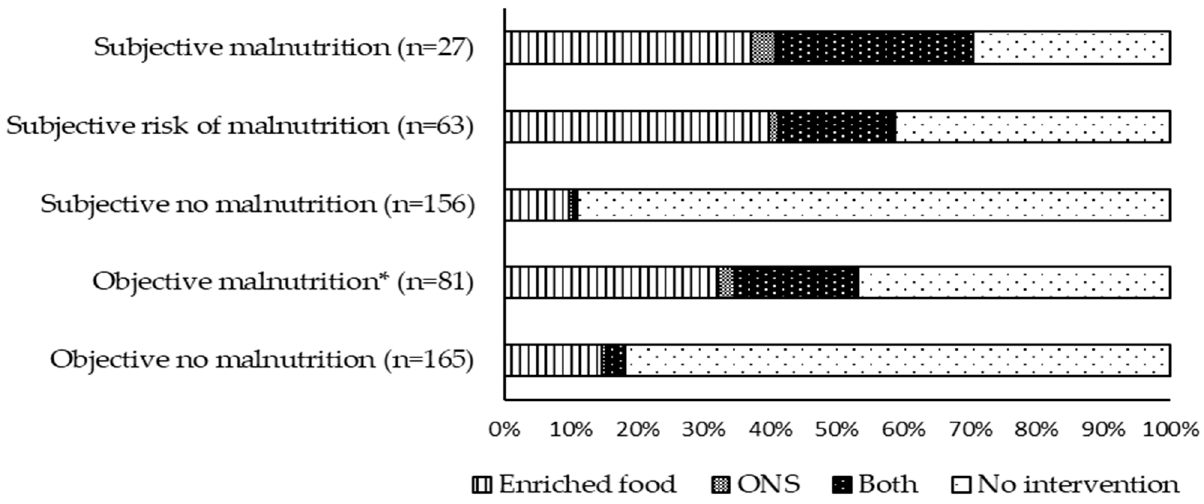
Figure 1. Proportion (%) of residents receiving nutritional interventions stratified by subjective judgement of malnutrition by nursing staff and objective rating of malnutrition (* BMI < 20 kg/m 2 or weight loss ≥ 5% in last 3 months or intake ≤ 1/4 of the meal).